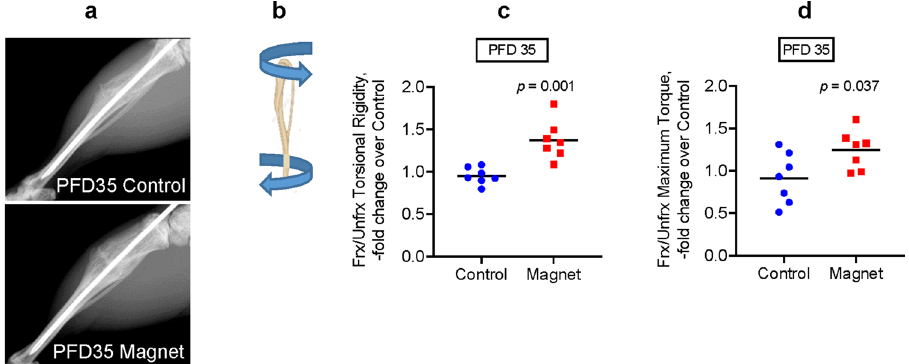
Figure 4. Electromagnetic field stimulation improves biomechanical properties after tibial fracture repair in mice. ( a ) X-Ray images of repaired tibiae on post-fracture day (PFD) 35; ( b ) Diagram illustrating the torsion test performed on tibia; ( c ) Torsional Rigidity values derived from the torsion test; ( d ) Maximum Torque values derived from the torsion test. Plots show actual data points and calculated means. Both fractured (Frx) and unfractured (Unfrx) tibiae were tested. Values in Frx bone are normalized to values in Unfrx bone to account for systemic changes after exposure to the electromagnetic field. Plots show actual data points and calculated means. P value was determined via the t